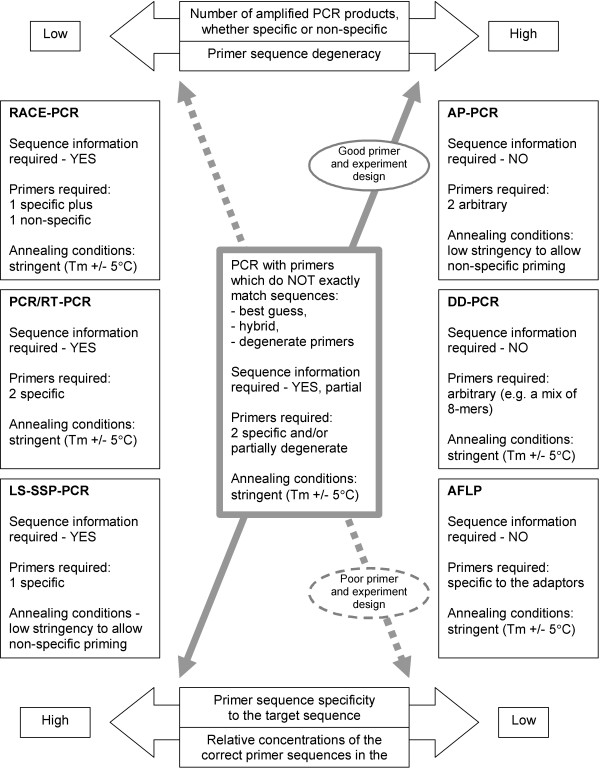
Overview of PCR-based strategies suitable for the amplification of cDNAs. For references see PCR/RT-PCR [14, 15], RACE-PCR [19], LS-SSP-PCR [23], AP-PCR/DD-PCR [24, 25] and AFLP [26]. The use of nested primers not shown as the principle which can be applied to any of the above or their combinations. A PCR amplification relying on the use of fully degenerate, partially degenerate (hybrid) or "best guess" primers occupies a place in-between the PCR approaches illustrated. The outcome of such PCR may vary, as schematically indicated in grey lines. The best case scenario indicated with solid grey line, the worst case scenario – with dashed grey line.